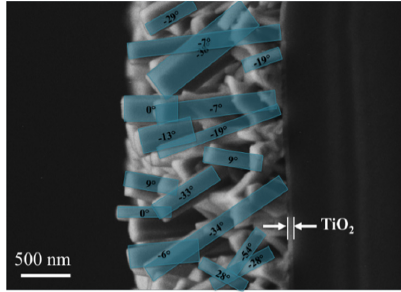
Figure 8. SEM micrograph of textured ZnO thin layer on TiO 2 /borosilicate glass. Cross section view. Image exhibits several ZnO nanorods and their axis inclination from substrate normal. Reproduced with permission from [53].